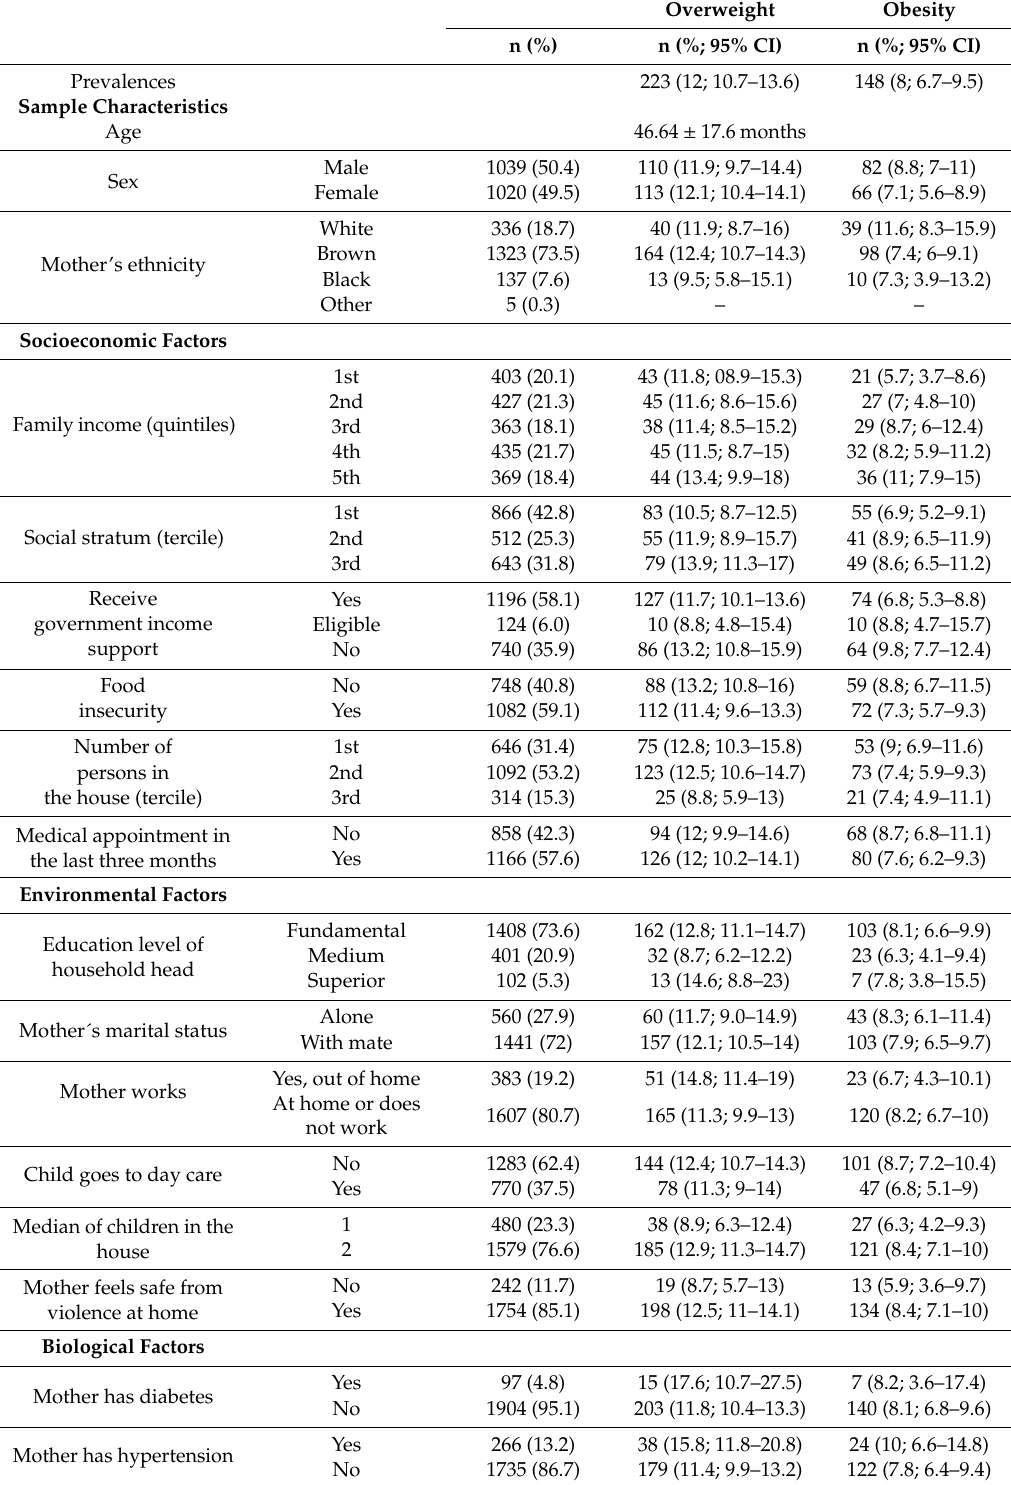
Table 1. Prevalence of overweight and obesity in children aged 2–6 years among demographic and socioeconomic groups, and by environmental, family, and nutritional factors, Cear á ,